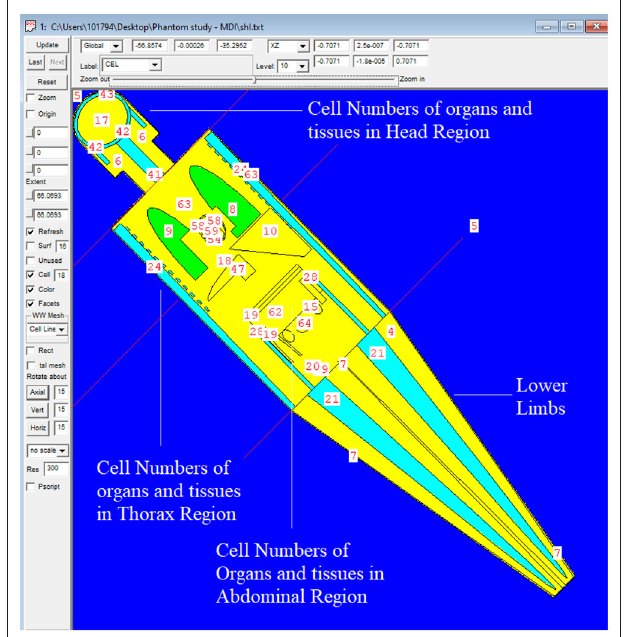
FIGURE 4 | The modified MIRD phantom, shielding materials, and their